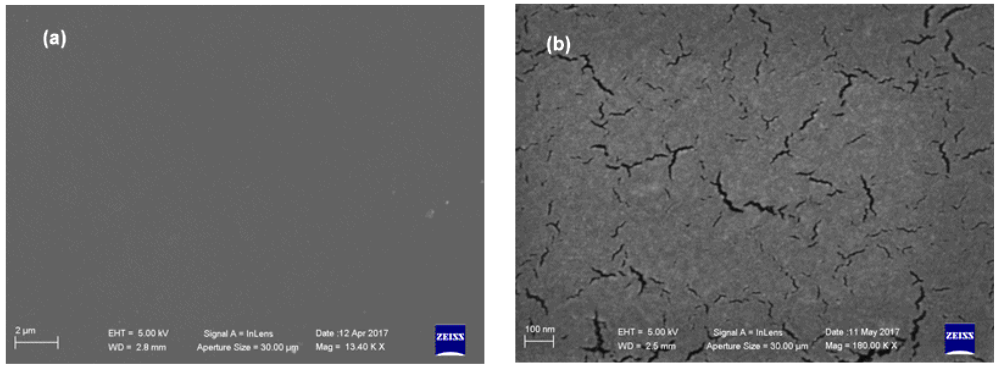
Figure 3. SEM microphotographs of PU_MD at different magnification: ( a ) 13 Kx and ( b ) 180 Kx.